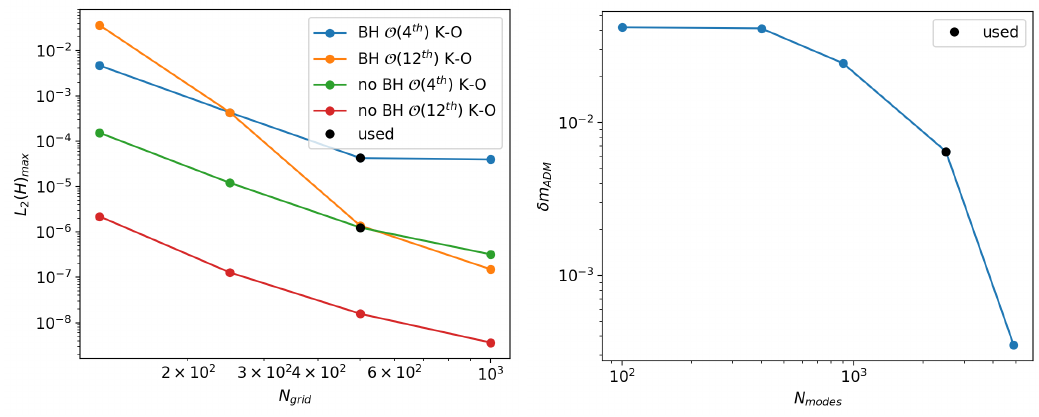
Figure 6 . Convergence of the L 2 norm of the Hamiltonian constraint with respect to the number of grid points (left) and convergence of the ADM mass with respect to the number of quantum mode functions used (right). The dots labeled with “used” are the ones that we use in figure 3 and figure 4.